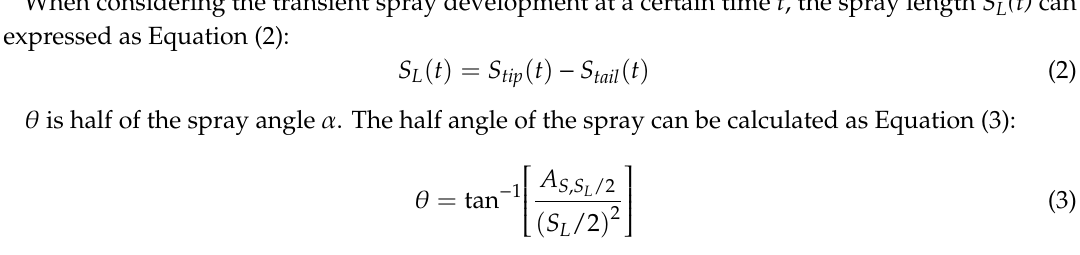
Figure 3. Definitions of the spray characteristics.